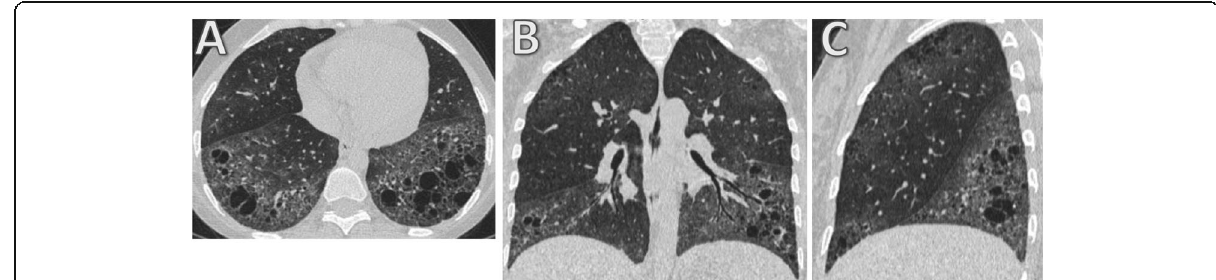
Fig. 4 A 22-year-old female patient diagnosed with systemic sclerosis presenting with progressive dyspnea. a – c Axial, coronal and sagittal reformatted images of HRCT chest (lung window) showing bilateral fairly symmetrical predominantly lower lobar and subpleural ground glass opacities and subpleural reticulations with reduced volume of both lower lung lobes. Bilateral predominantly lower lobar variable sized cysts are noted; findings impressive of interstitial lung disease (ILD) in the form of lymphocytic interstitial pneumonia (LIP)